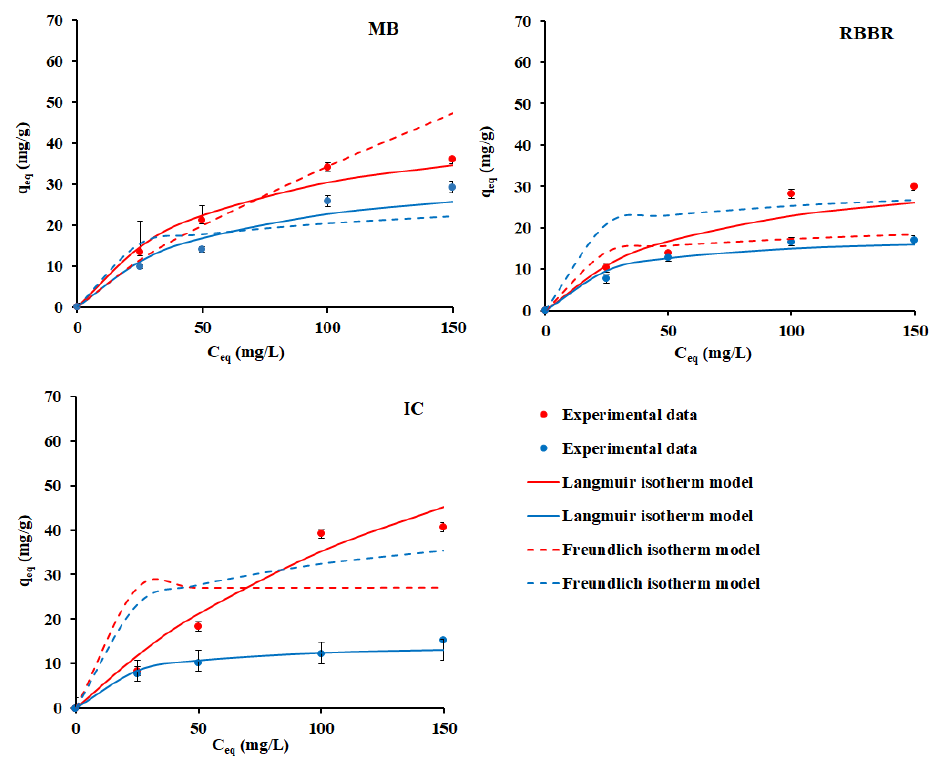
Figure 3. Langmuir and Freundlich isotherm models of adsorption of synthetic dyes MB, RBBR and IC by melanins from L. pulmonaria (red line); L. retigera (blue line) at 298.1 ◦ K. Solid line corresponds to the Langmuir isotherm model, dotted line corresponds to the Freundlich isotherm model. The main parameters, including the constants of the Langmuir and Freundlich equa- tions, were calculated and presented in Supplementary Table S2. Values q eq using the Langmuir and Freundlich models (Section 3.4.2) were consistent with the experimental data (Figure 3). According to the Langmuir model, the formation of a monomolecular layer on the surface of the sorbent does not involve interactions between the adsorbate particles [41,42]. According to the Freundlich model, adsorption occurs on an energeti- cally heterogeneous surface [43]. According to the type of isotherm and the obtained val- ues (R 2 ), the adsorption of synthetic dyes MB and RBBR by lichen melanins could be cor- rectly described by the Freundlich isotherm model (Figure 3; Supplementary Table S2), due to the presence of the heterogeneous adsorption centers in the melanin structure. The maximum dye adsorption capacity (q max ) was calculated according to the Lang- muir model. For melanin from L. pulmonaria it was 47.63, 36.03, 92.96 mg/g, while for mel- anin from L. retigera it was 34.97, 18.28, 14.72 mg/g for MB, RBBR and IC, respectively (Supplementary Table S2). These data suggest that the melanin from L. pulmonaria demon- strates higher dye adsorption capacity. Presumably, MB adsorption is caused by electro- static interactions between the -NH group dyes and negatively charged functional groups of melanin. Total amount of negatively charged functional groups in the melanin of L. pulmonaria was 5% more than that in the melanin of L. retigera (Table 3). Adsorption of anionic dyes is associated with the presence of hydrophilic centers in the structure of mel- anin [44]. RBBR contains both cationic and anionic functional centers, which can interact with the aromatic skeleton of melanins via π – π or n – π interactions, and therefore the mechanisms of adsorption of this dye by lichen melanins are more complex. A significant limitation of the effective RBBR adsorption is high molecular weight and a complex branched structure of this dye [45]. The highest adsorption capacity melanin from L. pul- monaria demonstrates towards the anionic dye IC (92.96 vs. 14.72 mg/g for the melanin from L. retigera ) that can be explained by interactions of the dye with the aromatic skeleton